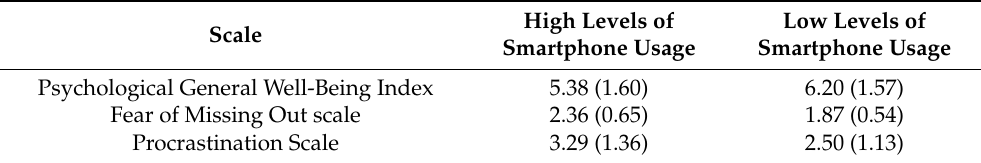
Table 3. Means (and standard deviations) on PGWBI, FoMOs and PS of the 2 groups: low levels of smartphone usage and high levels of smartphone